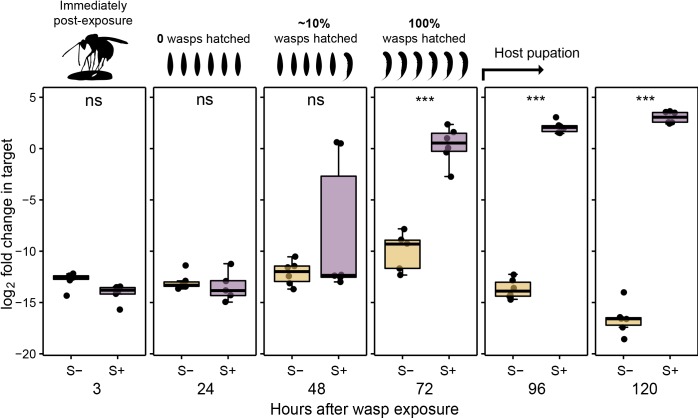
Hallmark of RIP attack in wasps begins soon after hatching.Abundance of depurinated ribosomes across a timecourse of L. heterotoma infestation of D. melanogaster in the presence and absence of sMel (n = 6 fly larvae or pupae per timepoint). Jitter points are the mean of two technical replicates per wasp-infested larva. Depurinated L. heterotoma ribosomes are detected 48 hours after oviposition in sMel-positive D. melanogaster, with increasing levels at subsequent timepoints. For all significant comparisons, p < .001 (t-tests). Legends above boxplots indicate parasitic wasp developmental stage at each time point indicated.